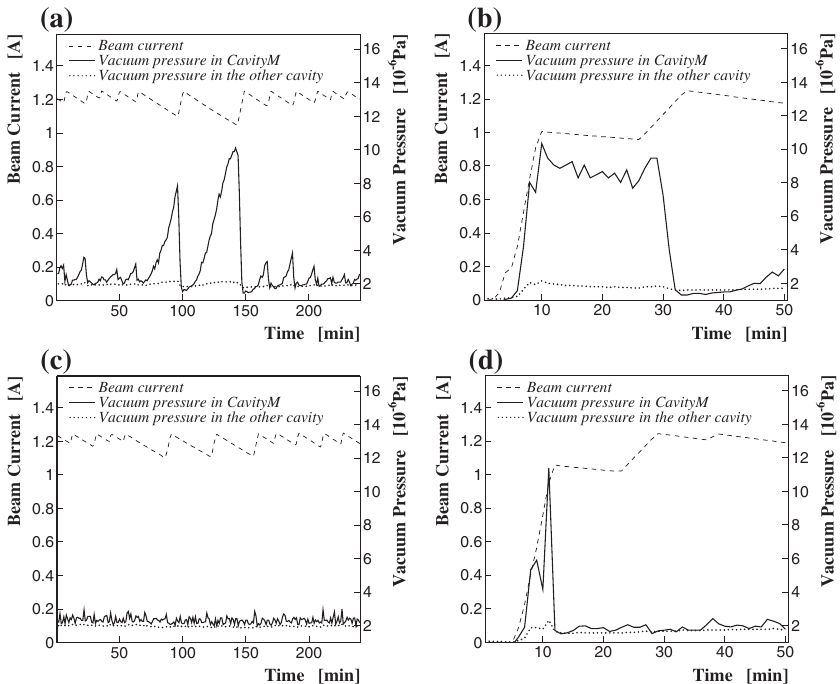
FIG. 6. Vacuum-pressure histories of CavityM (solid lines) and of the other cavity which has no multipactoring problem (dotted lines), together with histories of the HER beam current (dashed lines), for the periods of (a) the physics run in the CIM mode without the beam loading feedback [the trajectory of the operating point is shown in Fig. 4(e)], (b) the beam recovery without the beam loading feedback [the trajectory of the operating point for the early 30-five minutes is shown in Fig. 8(a)], (c) the physics run in the CIM mode with the beam loading feedback [the trajectory of the operating point is shown in Fig. 4(f)], and (d) the beam recovery with the beam loading feedback [the trajectory of the operating point for the early 15 minutes is shown in Fig. 8(b)]. The target input-power region is determined by scanning the vacuum pressure inside the diamond region. Figure 7 shows the vacuum data as a function of the input rf power.